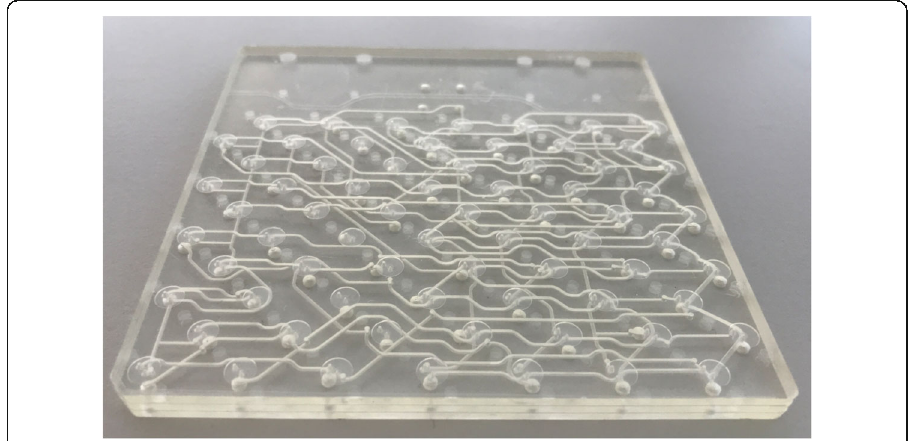
Fig. 3 ISAR chip (W x L x H 10,4 × 10,4 × 0,6 cm) with 70 on-chip membrane valves hosting multiple parallel fluid paths enabling point-to-point routing – the shown layout is designed for nine production